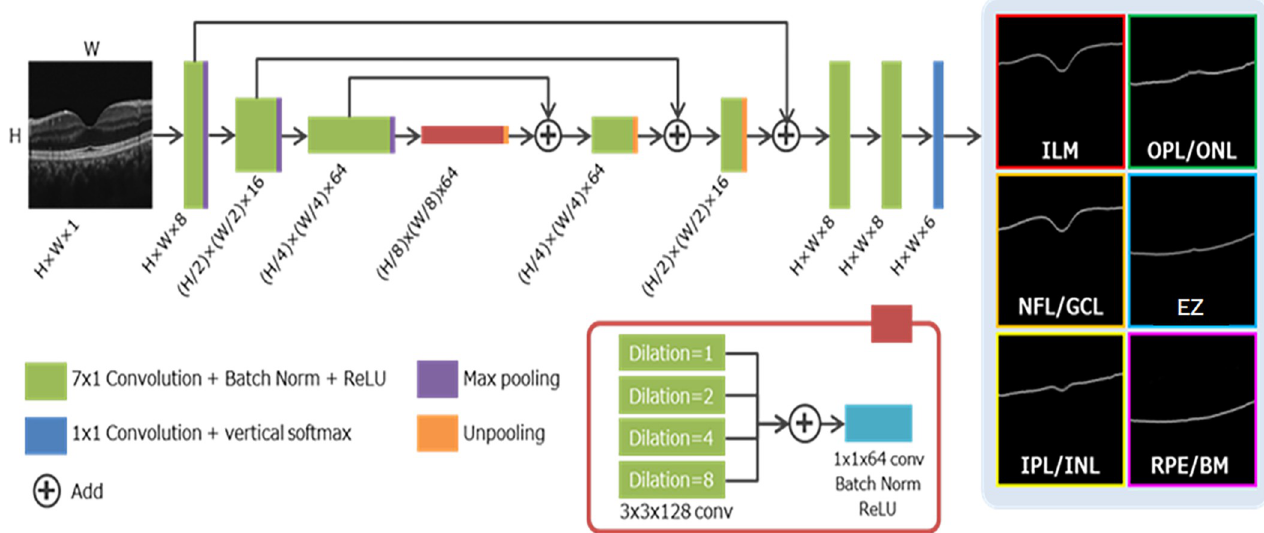
Fig 1. An OCT B-scan automatic image segmentation model was created based on U-Net. The output of this model is the probability distribution of each boundary layer, thus enabling the automatic detection of the boundary for each layer of the retina.